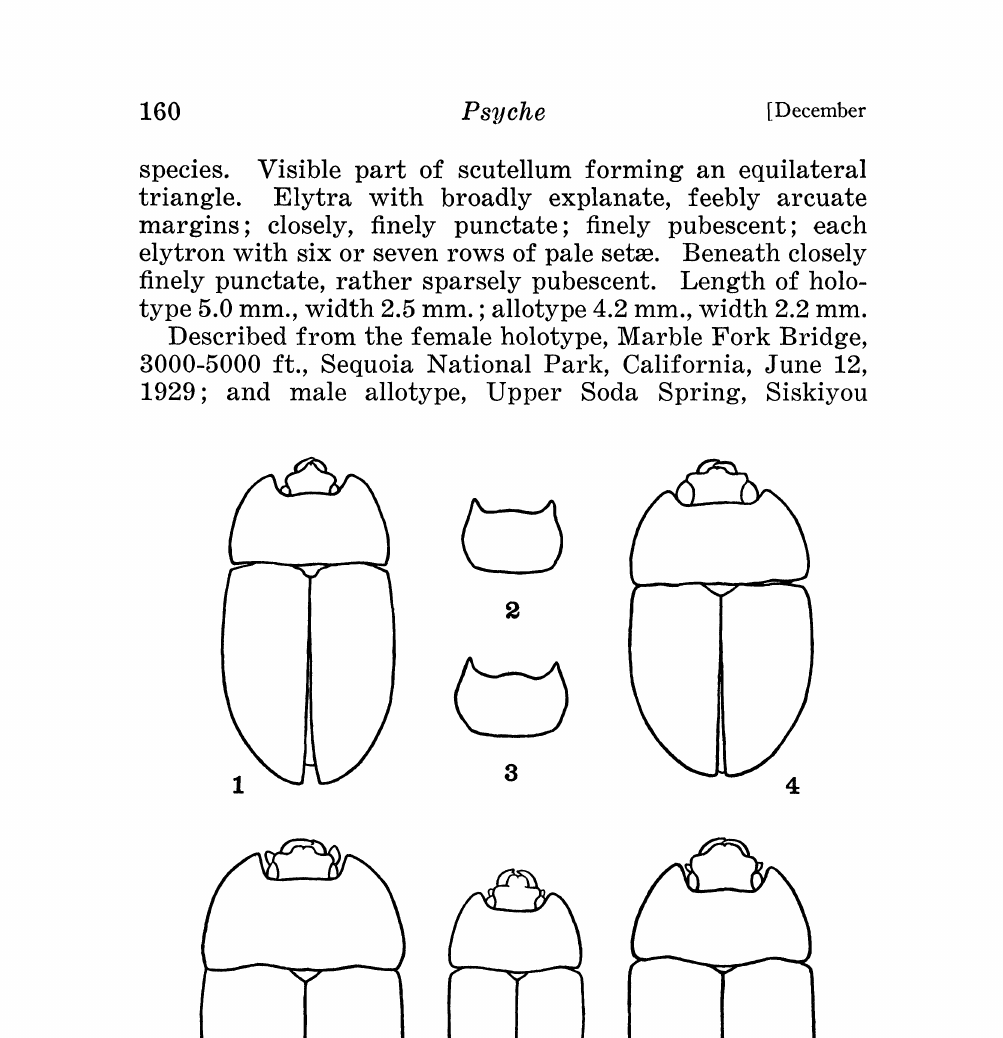
Figs. 1--7. 1, Amphotis schwarzi (cotype) 2, mentum of same; 3, mentum of A. ultcei (topotype) 4, Lobiopa puncata n. sp. (holotype.) 5, L. setosa (holotype of substriata) 6, L. oblonga n. sp. (holotype) 7, L. falli n. sp.